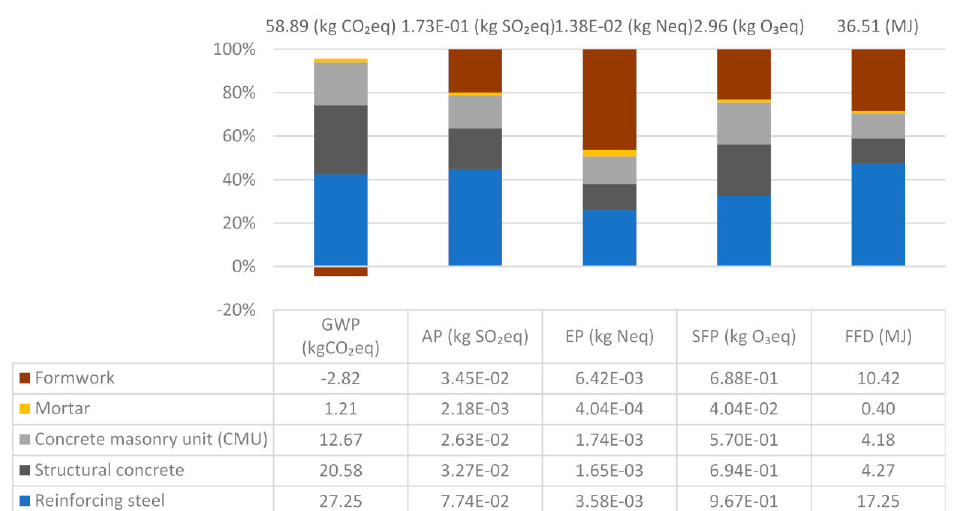
Figure 8. Detailed contribution of the di ff erent materials in S-1.